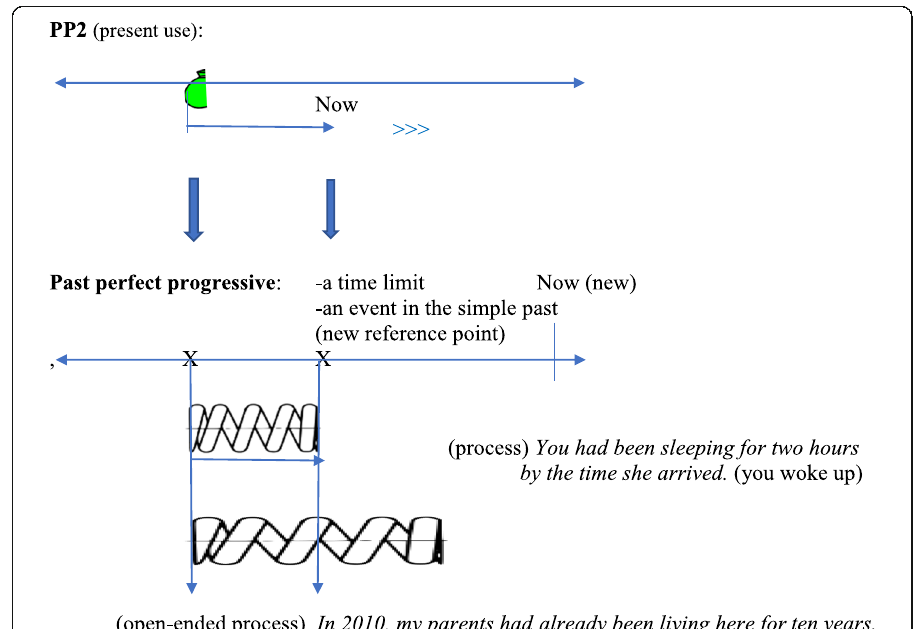
Fig. 11 The temporal characteristics of past perfect progressive, derived from PP2 (present